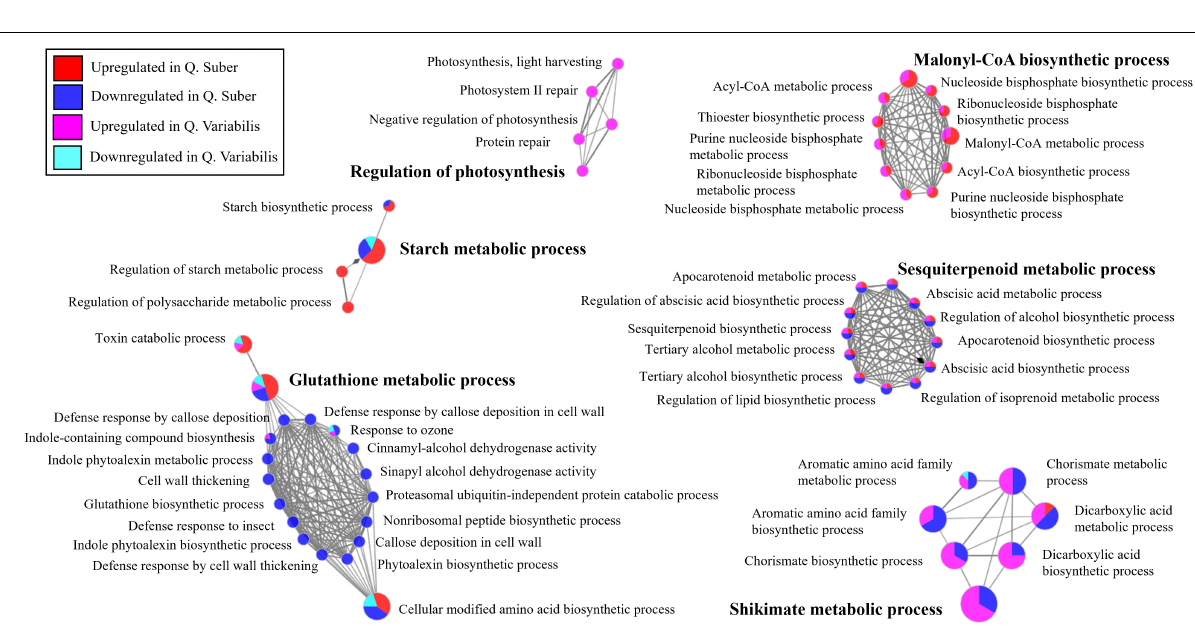
Frontiers in Microbiology |